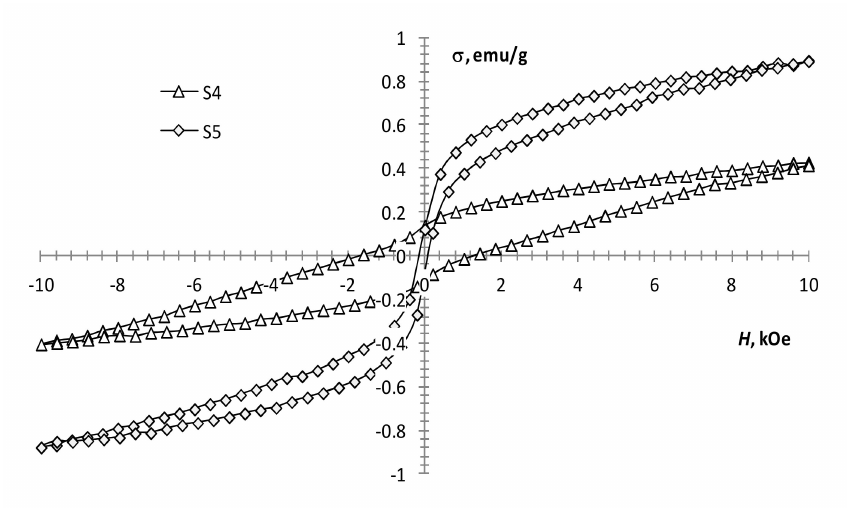
Figure 5. Magnetization loops of samples S4, S5.